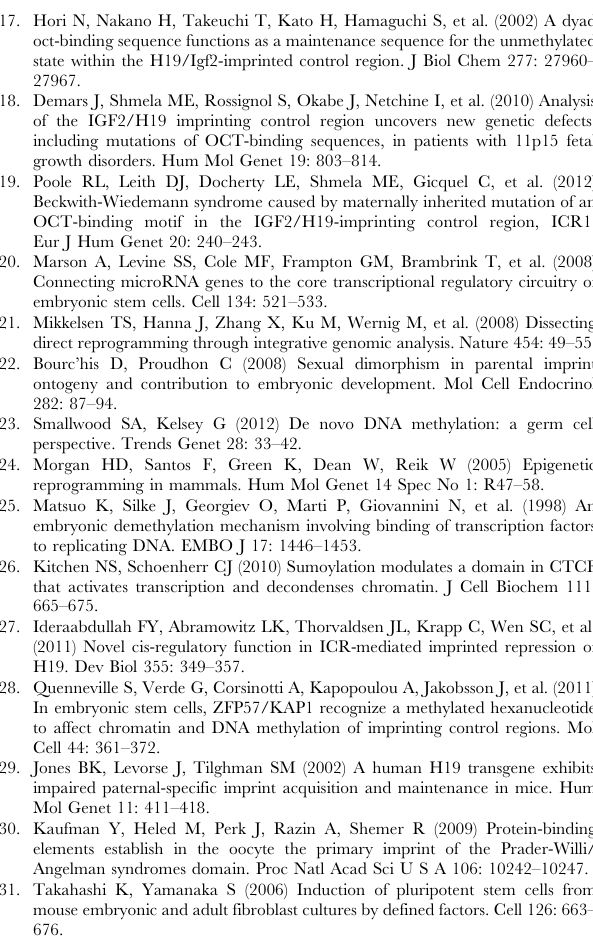
Fig. 2E. The amount of probe in each protein-DNA complex is represented as the percentage of total probe (bound and unbound) for each sample. The predicted percentage of Sox2-Oct4 ternary complex was determined by multiplying the fraction of probe bound by Oct4 in the absence of Sox2 and the fraction of probe bound by Sox2 in the absence of Oct4 (EMSA not shown). (B)